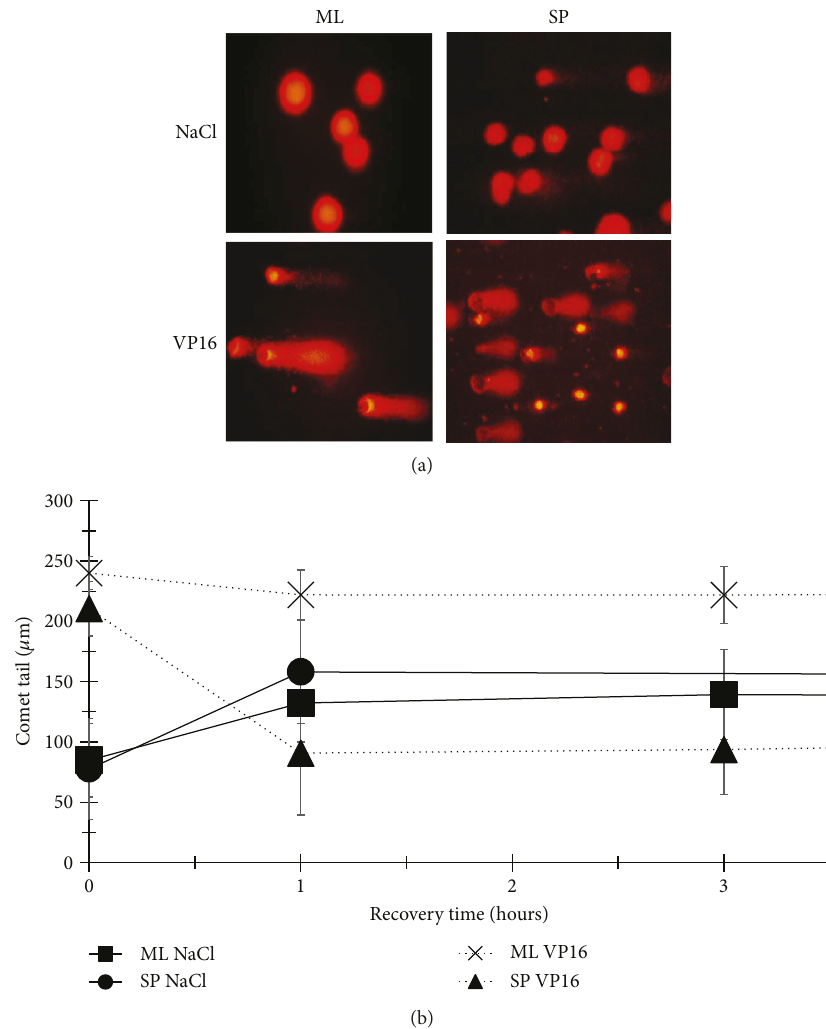
Figure 2: Spheres of HeLa cells repair DNA damage caused by VP16 more rapidly and e ffi ciently than MonoLayer cells. (a) Representative fl uorescence microscopy images of comet assays showing DNA damage caused by VP16 after 29 hours recovery. Short comet tail length, or its absence, indicates cells without damage; 40x objective. (b) Comet tail lengths in HeLa ML and SP within the fi rst three hours of